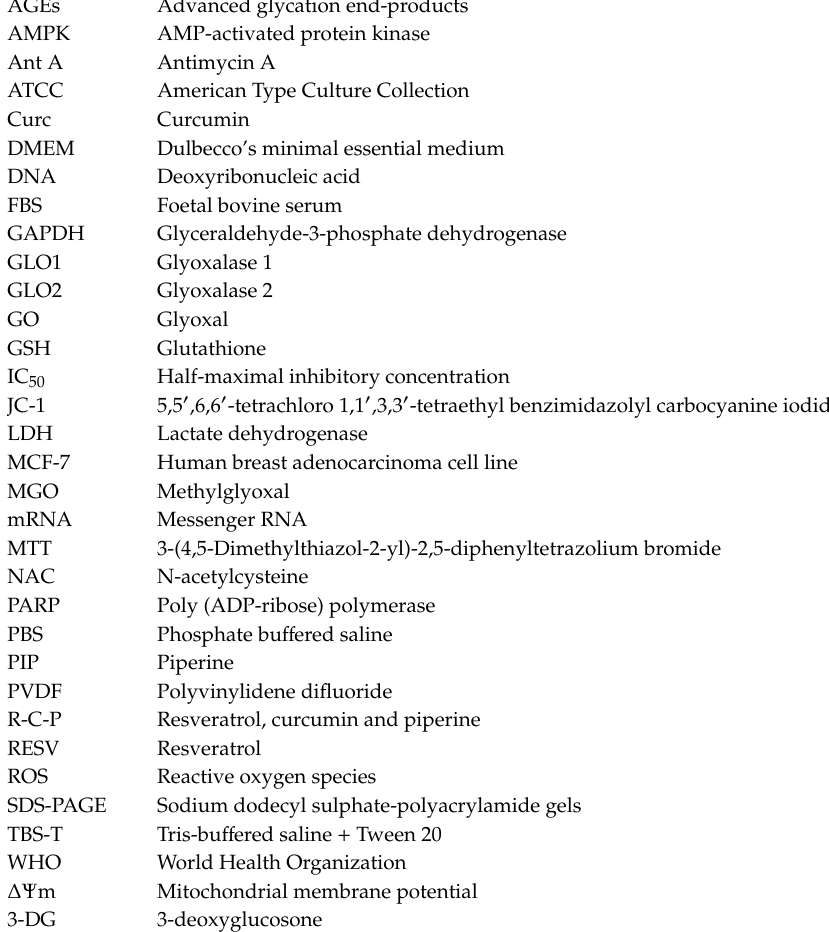
Figure S1. E ff ects of resveratrol, curcumin and piperine on the cell viability of MCF-7 cells determined by the trypan blue dye exclusion assay. Figure S2. The e ff ects of GSH and NAC on the cell viability of MCF-7 cells by the MTT method. Figure S3. GLO1 activity in MCF-7 cells after resveratrol, curcumin and piperine treatments. Figure S4. Resveratrol, curcumin and piperine e ff ects on GLO1 in MCF-7 cells at the protein